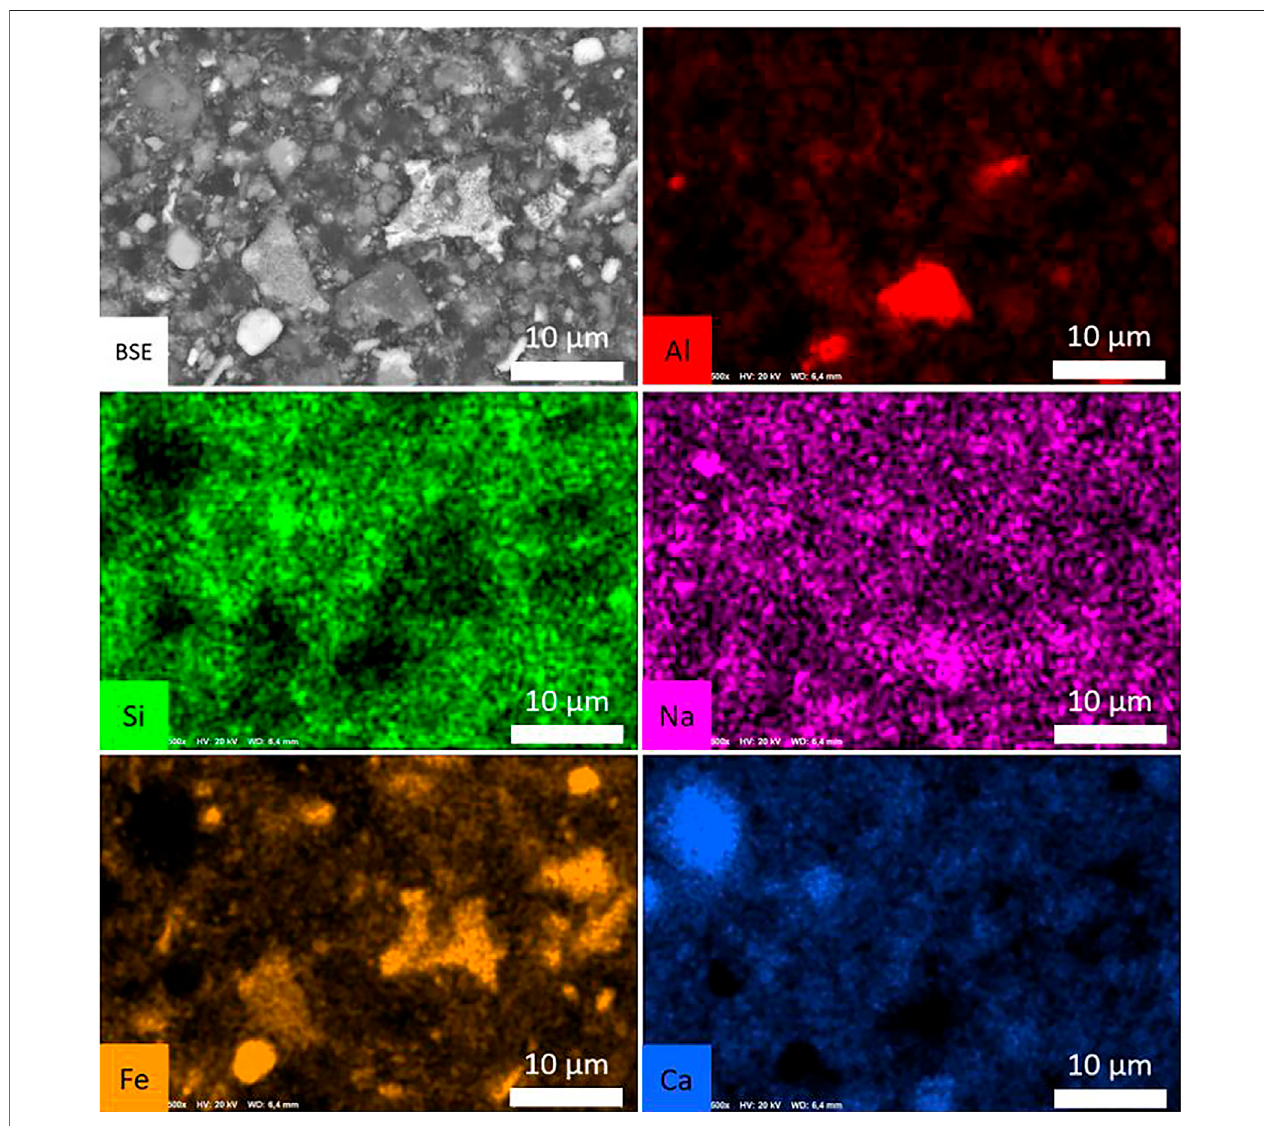
FIGURE 7 | SEM image and elemental maps of the reacted R³-like paste.